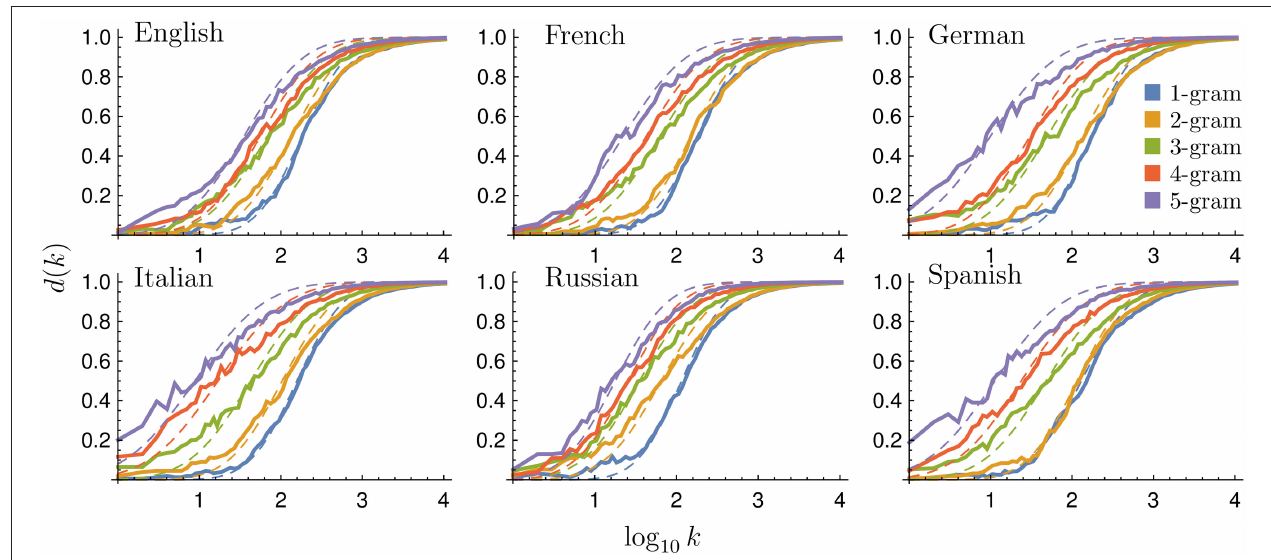
FIGURE 2 | Rank diversity for different languages and N -grams. Binned rank diversity d ( k ) as a function of rank k for all languages and N values considered (continuous lines). We also include fits according to the sigmoid in Equation (1) (dashed lines), with µ , σ , and the associated e error summarized in Table 1 . Windowing is done averaging d ( k ) every 0.05 in log 10 k